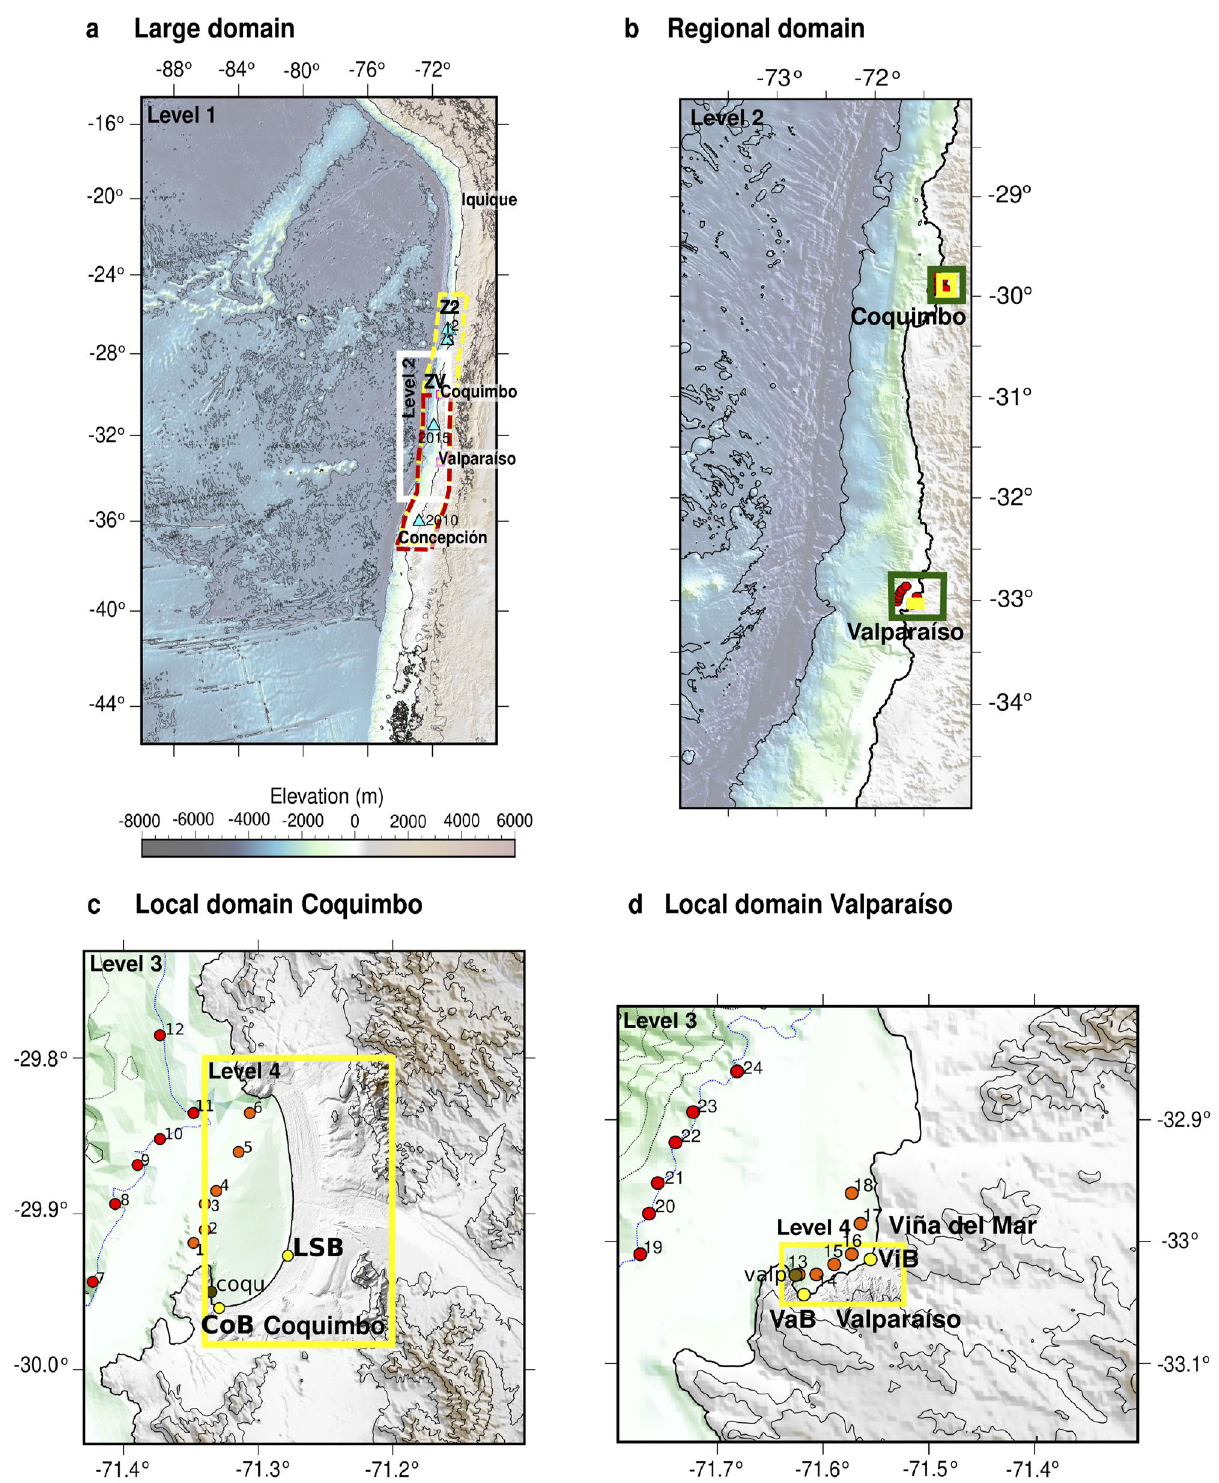
Figure 1. Topo-bathymetry and nested domains used for tsunami numerical simulations with Tsunami- HySEA. ( a ) Basin domain (Level 1) at spatial resolution of 1 arcmin. Yellow dashed box shows Zone 2 of Poulos et al. 63 and ZV the study area. The 2010 and 2015 (cyan triangles) correspond to the location of centroids taken from the Global Centroid Moment Tensor database. White box denotes Level 2. ( b ) Regional (Level 2) grid with resolution of 15 arcsec. Black boxes indicate the two local domains. c and d) Local (Level 3) grid with resolution of 1.875 arcsec. Red and orange dots indicate the location of offshore virtual buoys used to obtain input time series, located at the isobaths of 200 m and 50 m respectively. Yellow dots show the location of inland numerical buoys that are the target of the network. Yellow boxes denote the high resolution grid (Level 4, 0.234 arcsec, ∼ 7 m). Panels c and d correspond to Coquimbo-La Serena and Valparaíso-Viña del Mar,